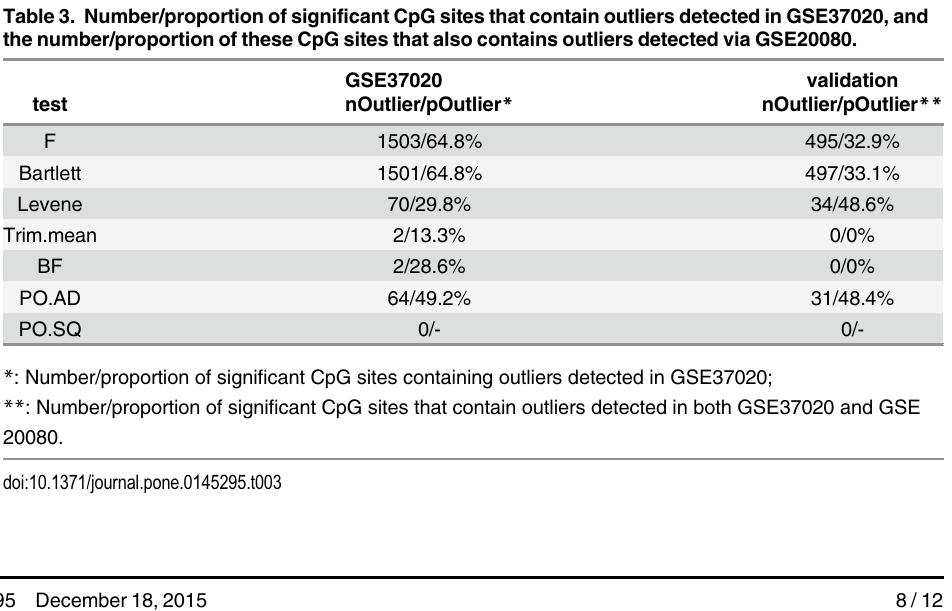
We next checked the parallel boxplots of DNA methylation level versus case-control status for the top 1 CpG site (i.e., having the smallest p-value for testing equal variance) obtained by